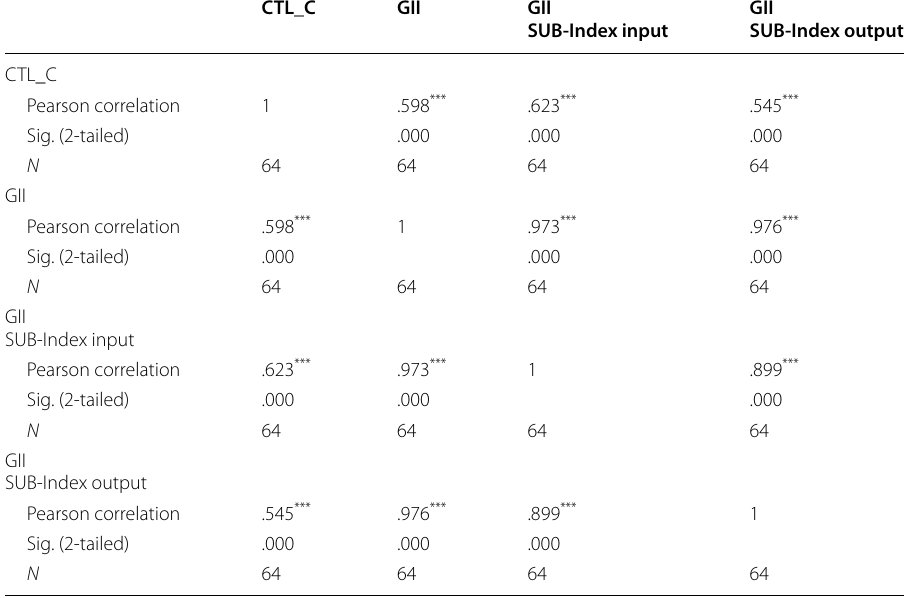
Table 3 Correlation data Uz